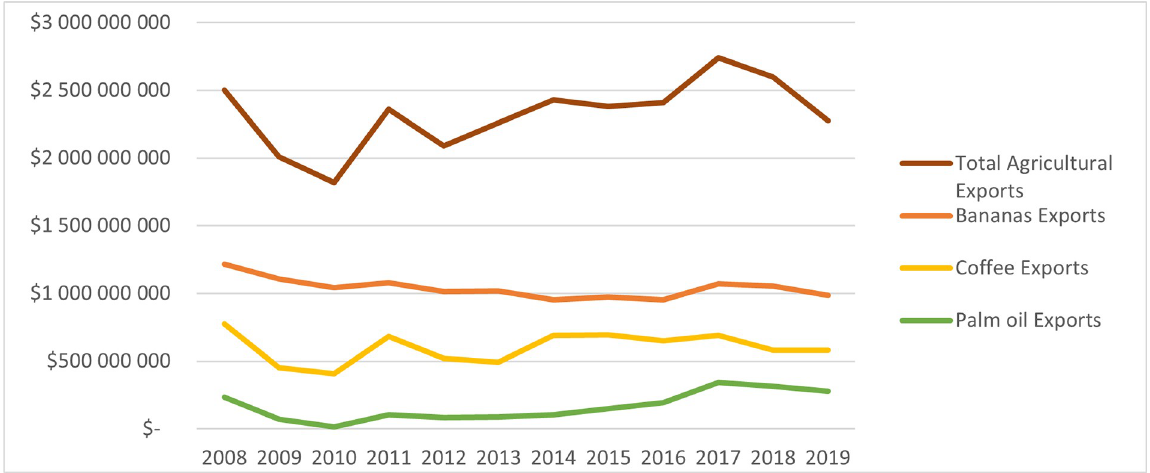
Fig 4. Trade value of Colombian agricultural commodities exported to the European Union. Source: Prepared by the author, based on data from UN Comtrade [37] and Atlas of Economic Complexity [31].